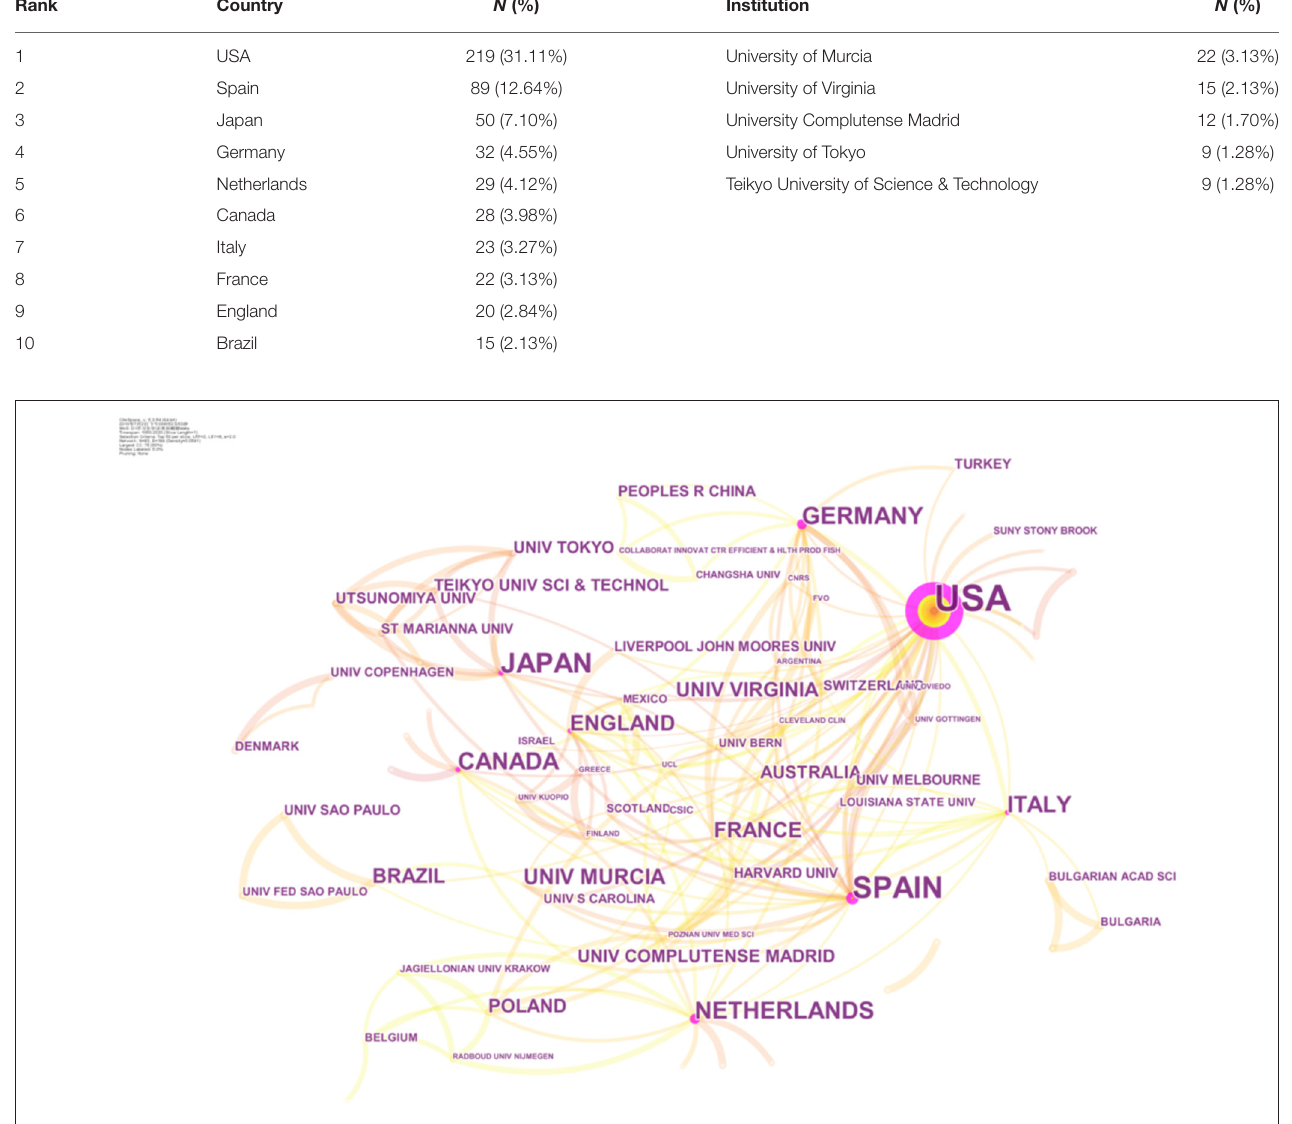
between epilepsy and circadian rhythm, as well as possible novel